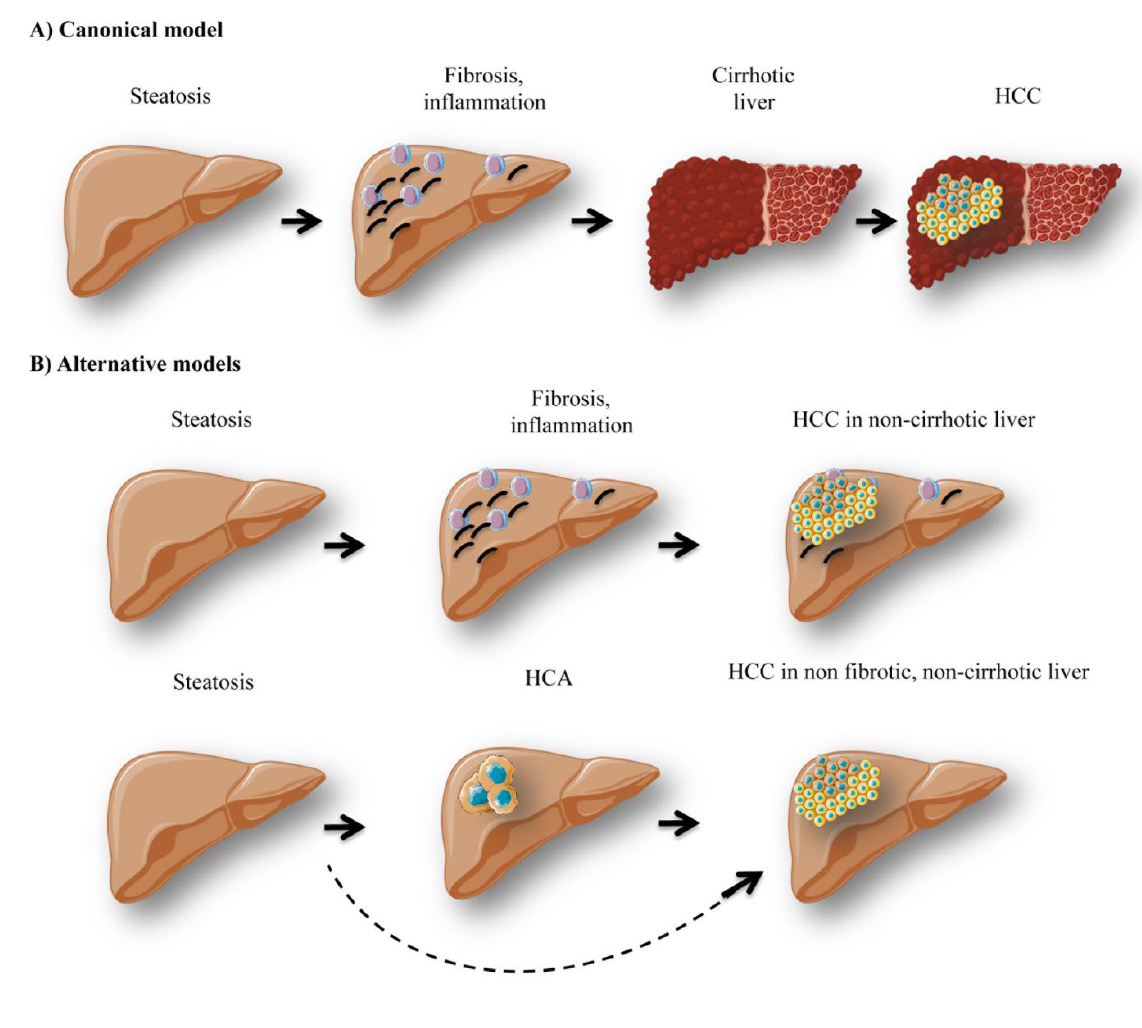
FIGURE 3: Different models of hepatocellular carcinoma development. The canonical model of hepatocellular carcinoma (HCC) devel- opment (A) stipulates that patients with hepatic steatosis further develop inflammation / immune cell infiltration and fibrosis. Later on, excessive fibrosis and inflammation can lead to cirrhosis development and HCC. However, alternative models of hepatocarcinogenesis (B) have been observed in obese / GSDI patients. Indeed, steatotic patients, who do not present cirrhosis, can also develop HCC de novo , since fatty livers are favorable for carcinogenesis. Moreover, in GSDI patients, HCC can develop in non-fibrotic, non-cirrhotic liver. These tumors arise from the transformation of hepatocellular adenoma (HCA) to